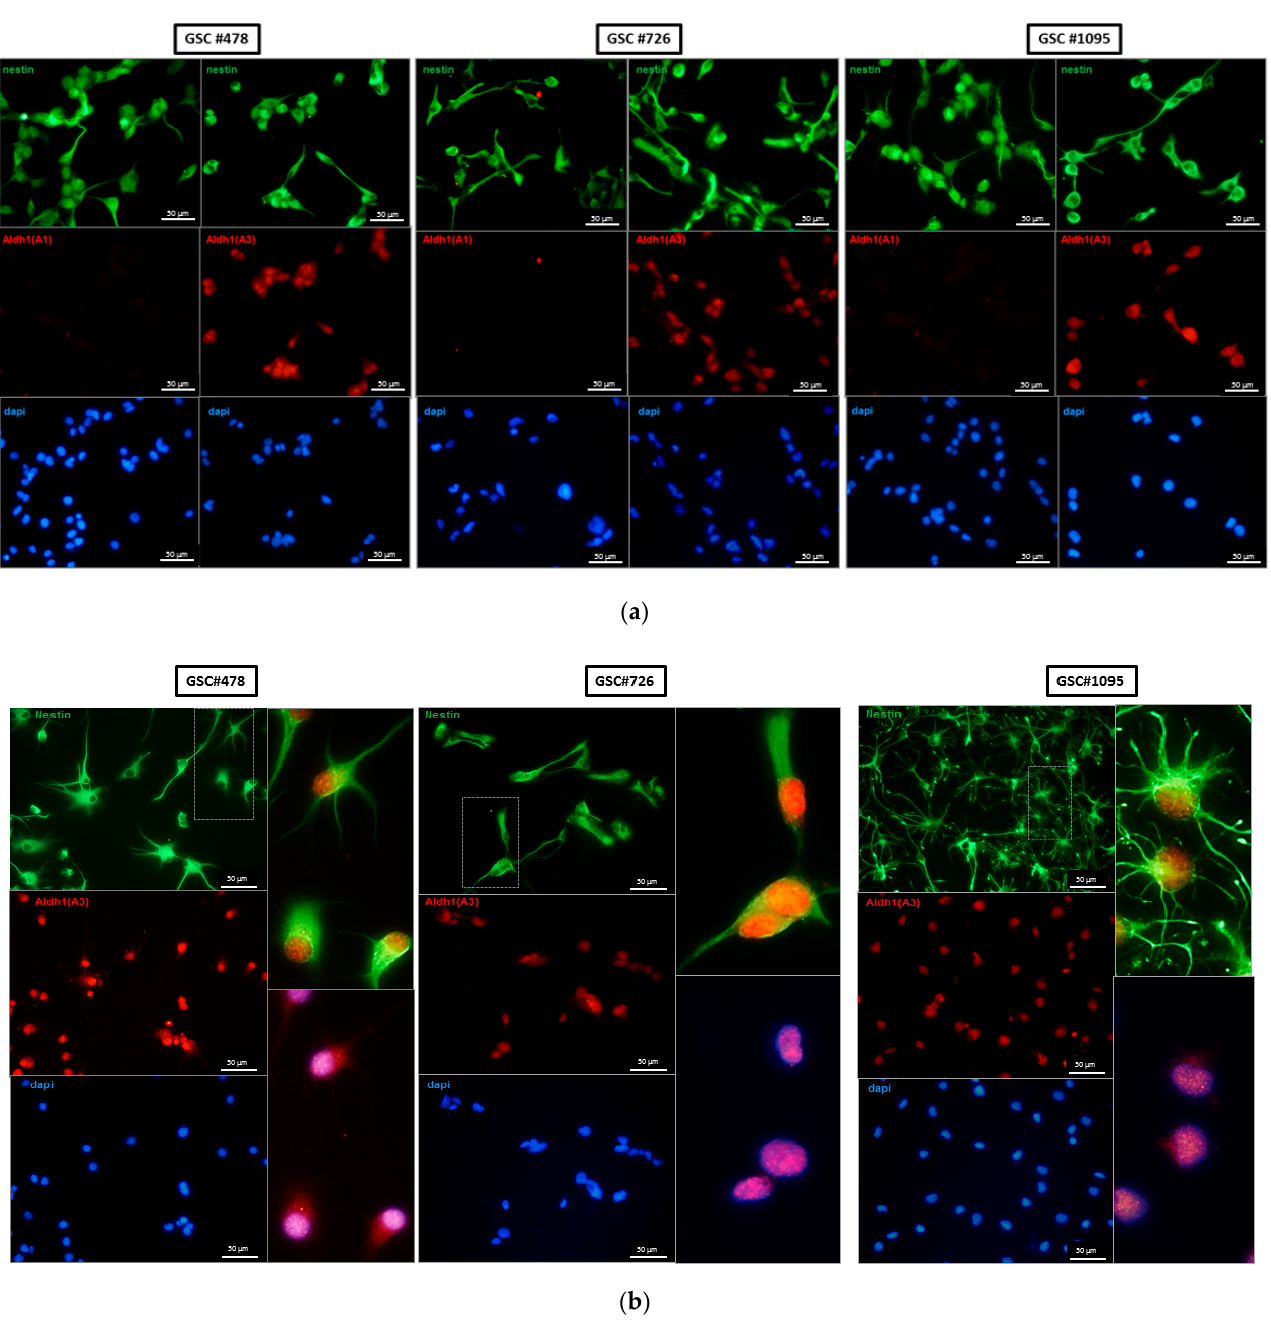
Figure 3. Assessments of ALDH1A1 and ALDH1A3 expression in GSCs by immunofluorescence staining. ( a ) GSCs cultured under self-renewal-promoting conditions and co-stained with anti-ALDH1A1 or anti-ALDH1A3 (red) and anti-nestin (green) antibodies. Counterstaining with DAPI. ALDH1A3 but not ALDH1A1 expression is readily detectable in self-renewing GSCs. Magnification 20×. Scale bars corresponds to 50 µM. ( b ) ALDH1A3 expression persists in GSCs under differentiation-inducing condition. GSCs were propagated under differentiation-inducing condition (withdrawal of self-renewal-promoting factors bFGF and EGF) and co-stained with anti-ALDH1A3 (red) and anti-nestin (green) antibodies. Counterstaining by DAPI. Magnification 20×. Scale bars correspond to 50 µM. Insets show enlarged images of individual cells demarcated by broken lines. The ALDH1A3 signal is readily seen in both the nuclear and cytoplasmic compartments.